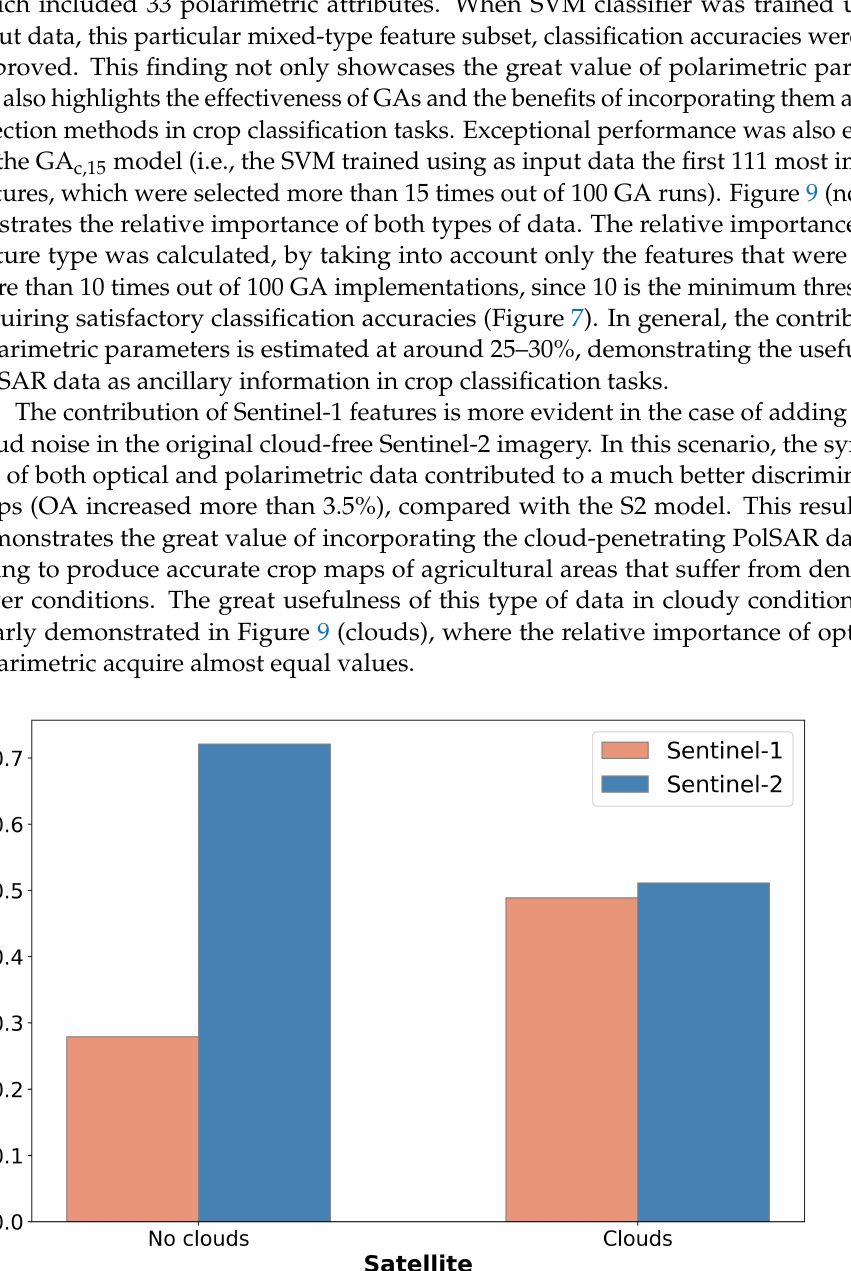
Figure 9. The aggregated importance of Sentinel-1 and Sentinel-2 features with and without